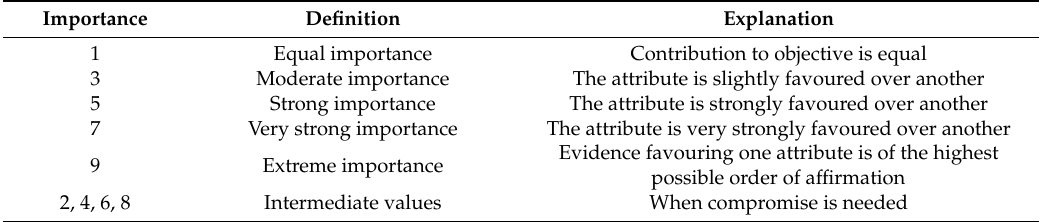
Table 1. Pairwise comparison point-based rating scale of AHP [49].